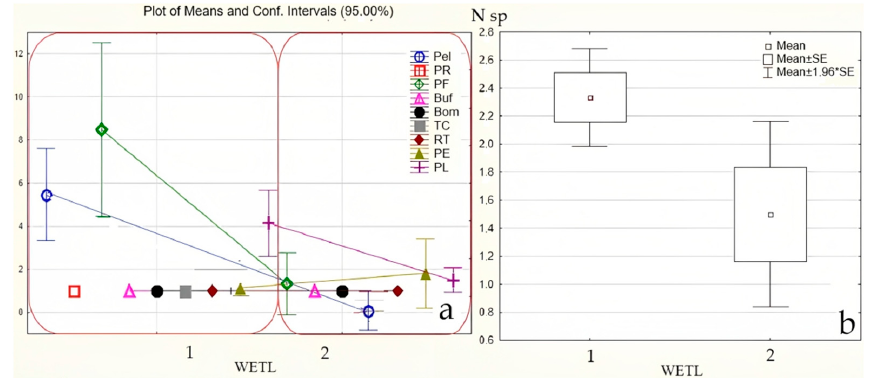
Figure 4. Number of individuals of different amphibian species counted in Silene Nature Park, South East of Latvia, in 2022 using method 2.2.3 ( a , mean/pond, designations in the text) and the average number of amphibian species (“N sp”, mean/pond, b ), “wetl”: 1—geographically isolated